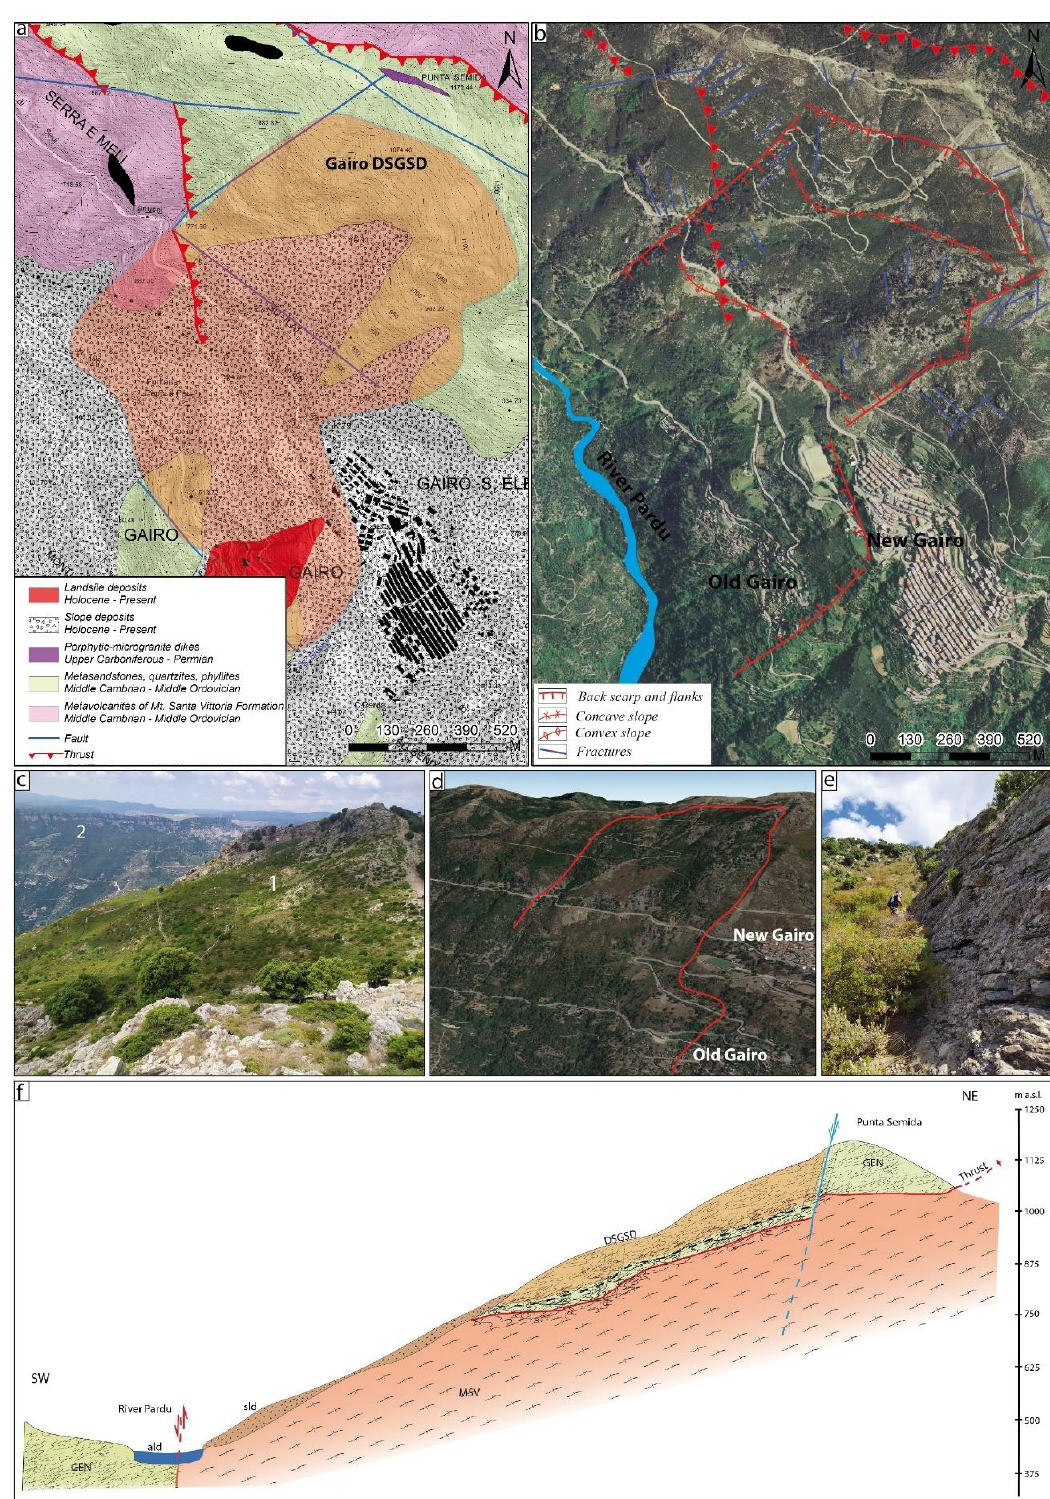
Figure 8. ( a ) Geological map of the Gairo slope with the DGSD localization. ( b ) Orthophoto with the main geomorphological feature of the DGSD. ( c ) Photo of the DGSD head. (1) Crown; (2) right slope of the Pardu River; ( d ) photo showing a 3D view with the DGSD border marked in red; ( e ) linear flank of the DGSD; ( f ) interpretative geological cross-section of the DGSD showing it (in transparent orange) sliding on the highly fractured rock due the underlying dip-slope Paleozoic thrust. Geolithological legend: MSV — Monte Santa Vittoria Formation; GEN — Filladi del Gennargentu Formation; ald — current alluvial deposits; sld — slope deposits.